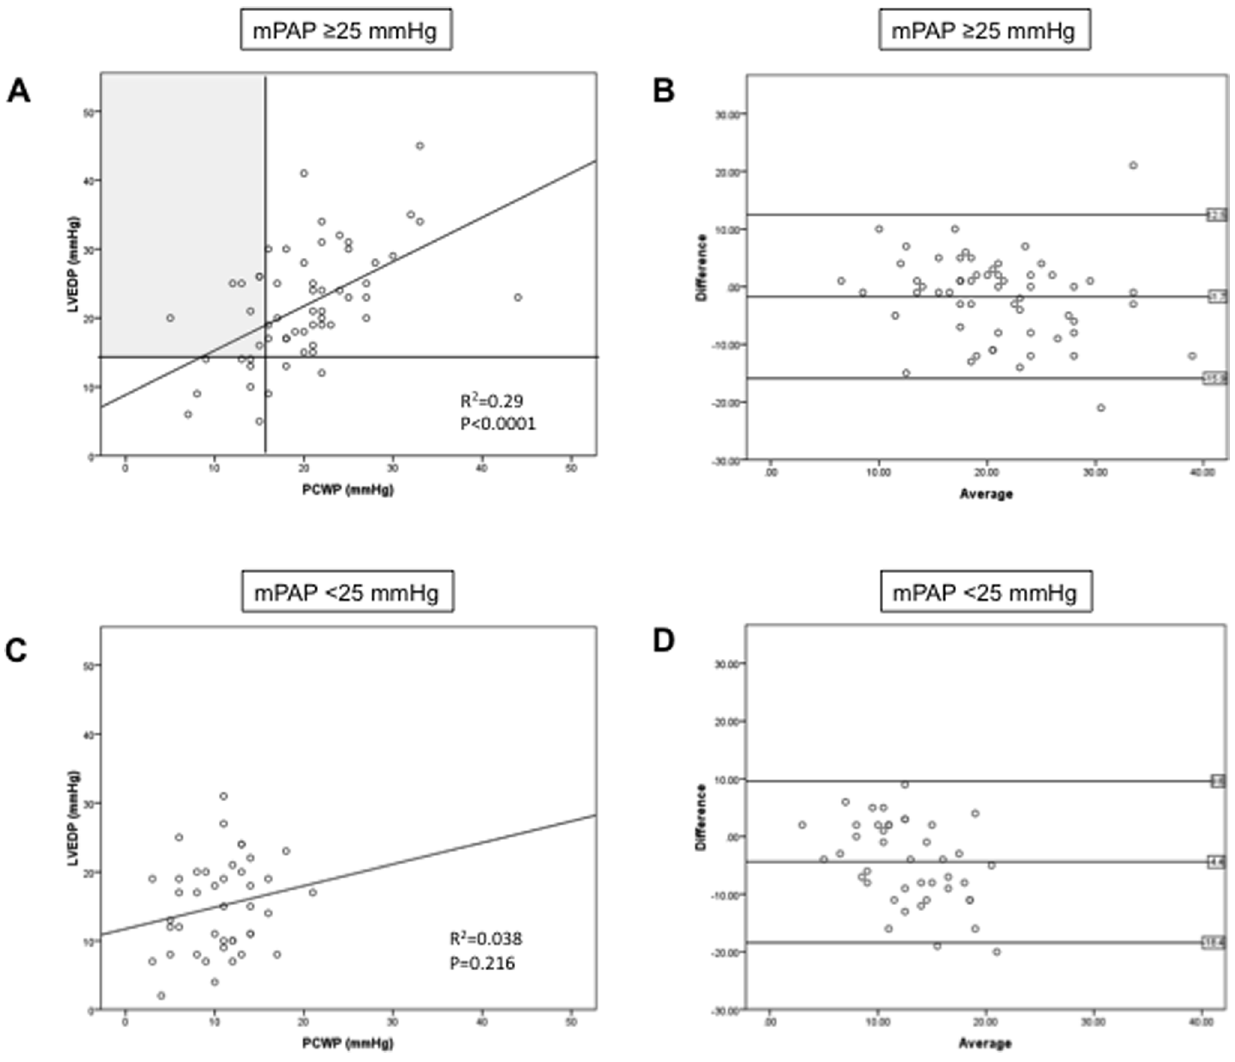
Figure 4. Correlation and agreement between PCWP and LVEDP in patients with (A, B) or without (C, D) pulmonary hypertension. Vertical line in (A) divides patients in patients with PCWP # 15 mmHg or . 15 mmHg; horizontal line divides patients in patients with LVEDP # 15 mmHg or . 15 mmHg. Shaded area in (A) represents the patients with PCWP # 15 mmHg, but LVEDP . 15 mmHg, thus indicating patients that would have been incorrectly classified as pre-capillary PH in absence of LVEDP measurement. See fig. 3 for explanation of Bland-Altman plot